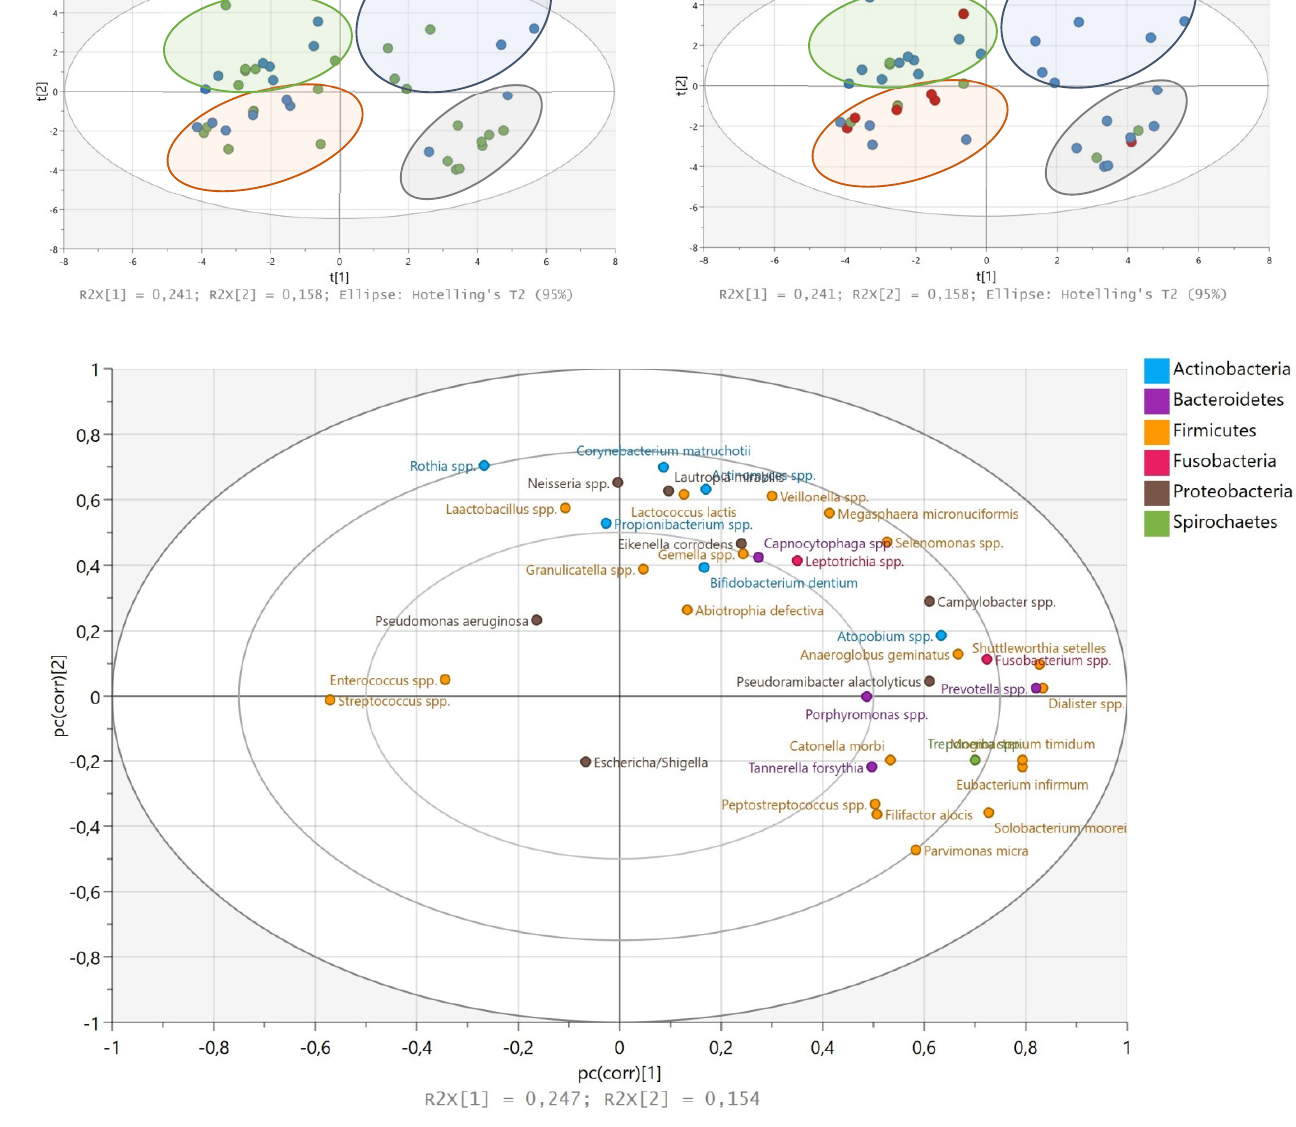
Figure 6. PLS-DA with root canal samples was performed based on the taxonomic profiles at the genus level. Different colors of points in plots were represented for different groups: ( A ) the blue points represent samples from patients with secondary infection, the green points represent samples from patients with primary infection; ( B ) the blue points represent samples from periapical periodontitis patients, the green points represent samples from endo–perio patients, and the red points represent samples from pulp necrosis patients; ( C ) the correlation loadings plot obtained in partial least square-discriminant analysis (PLS-DA) represent bacterial genera included in the analysis.